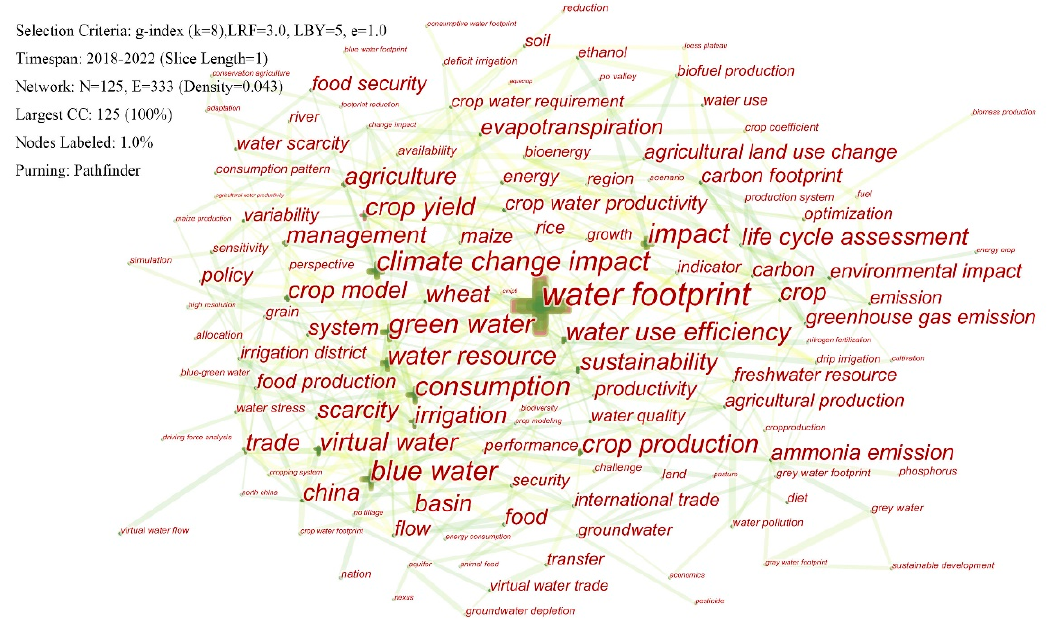
Figure 8. Co-occurrence network of keywords from 2018–2022.